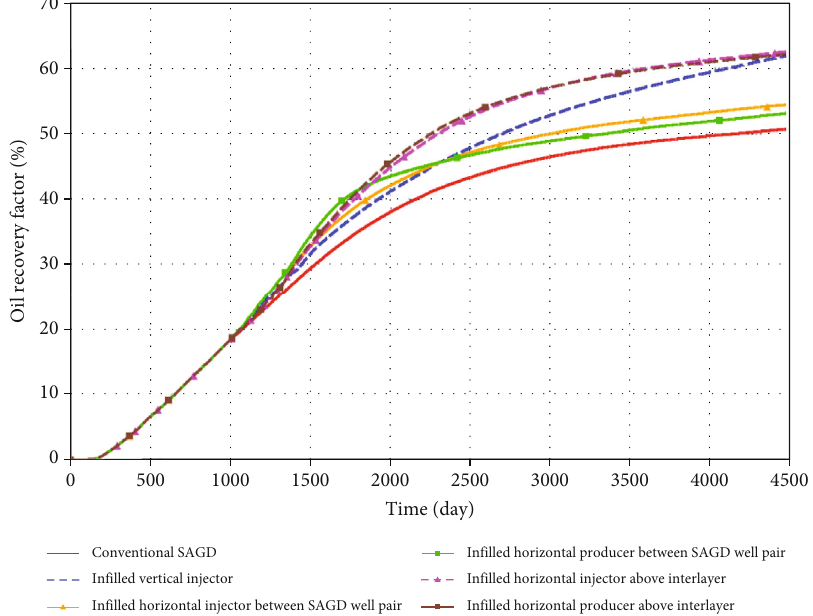
Figure 14: Production characteristics of the di ff erent schemes for model